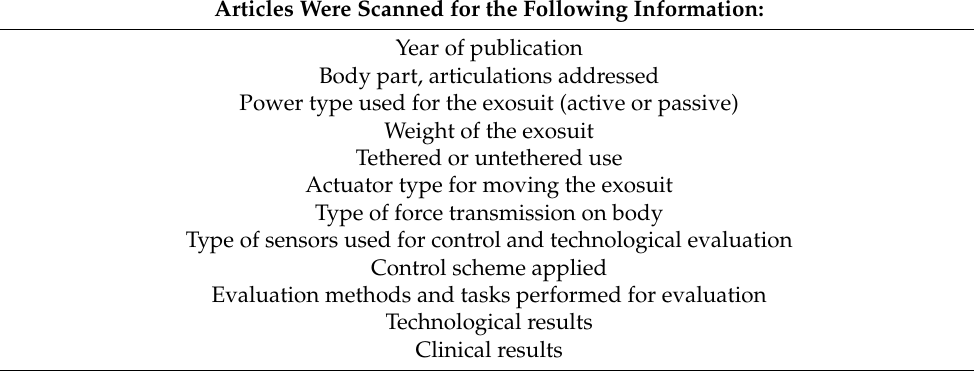
Table 1. Data extracted for analysis. Articles Were Scanned for the Following